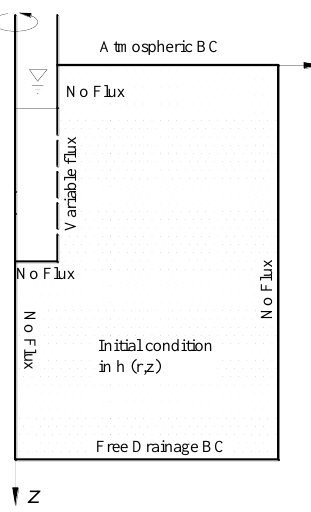
Figure 1. The transport domain with applied initial and boundary conditions.